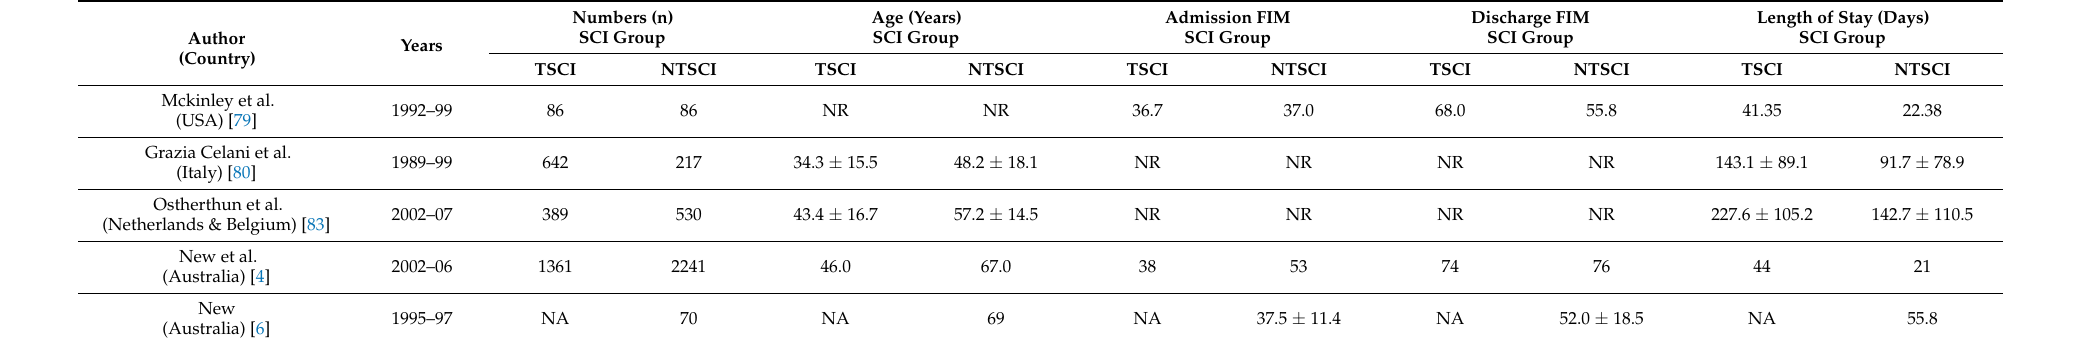
Table 5. Functional Impairment Measure (FIM) and Length of Stay comparison; TSCI, Traumatic SCI; NTSCI, Non-Traumatic SCI; NR, Not Reported; NA Not